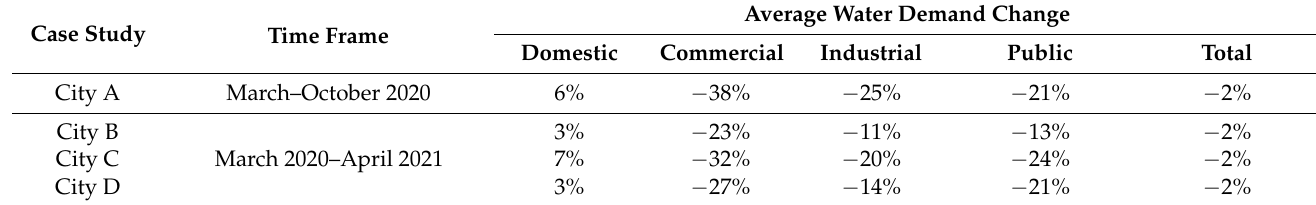
Table 3. Average water demand changes by case